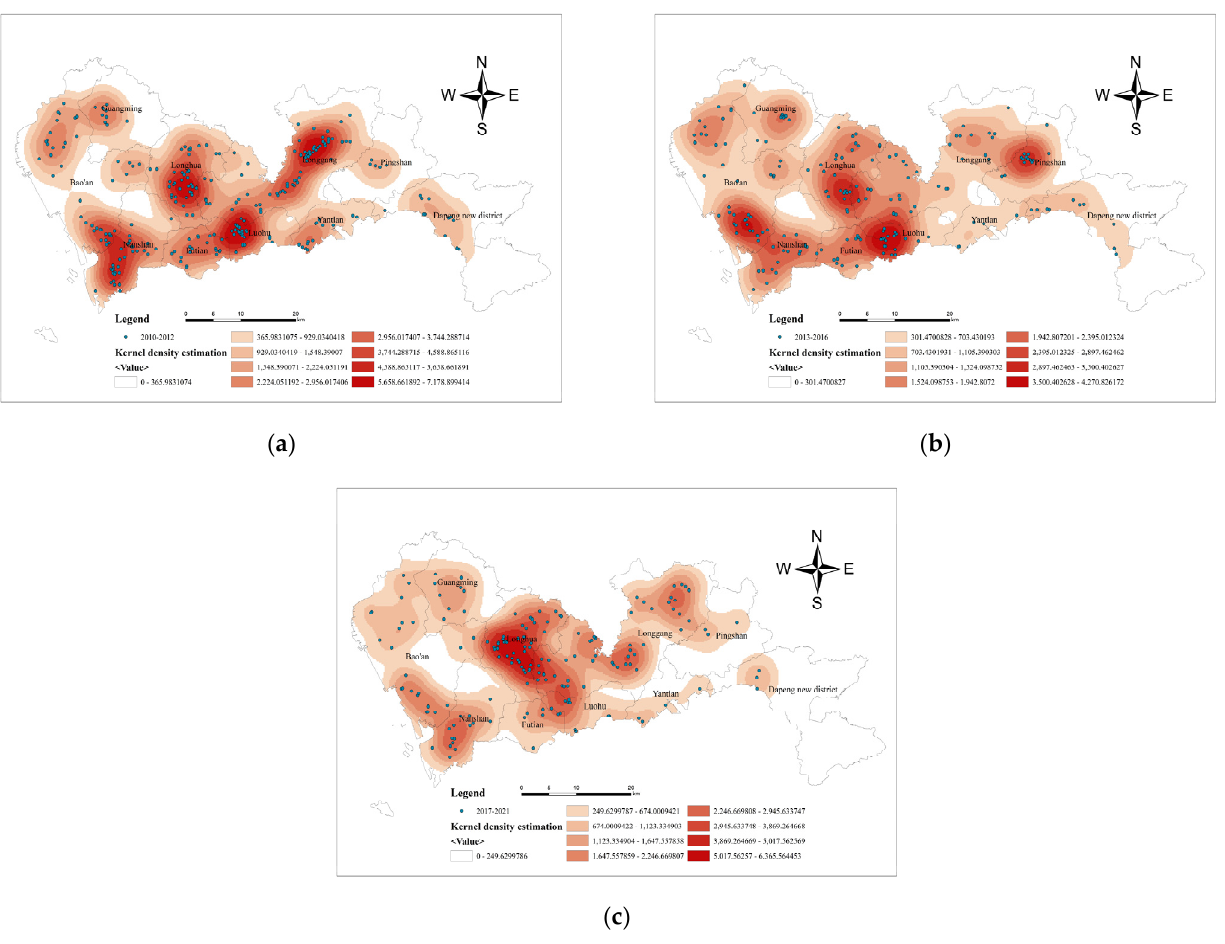
Figure A3. The distribution of UR projects in different years: ( a ) 2010–2012; ( b ) 2013–2016; and ( c ) 2017–2021.